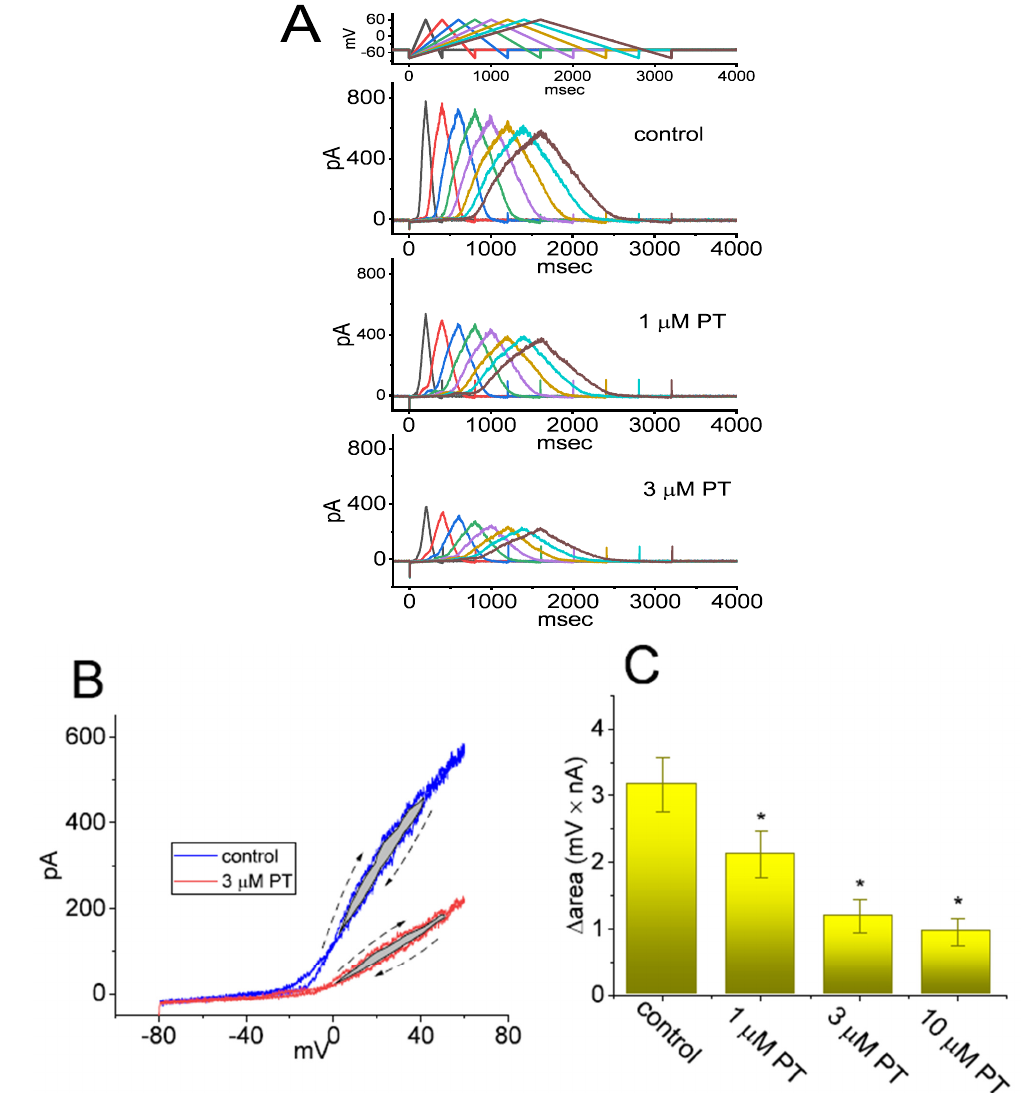
Figure 6. Effect of PT-2385 on I K(DR) activated in response to upright isosceles-triangular ramp voltage (ITRV) with varying durations (from 0.4 to 3.2 s), utilized to mimic different depolarizing or repolarizing slopes of bursting patterns in electrically excitable cells. Cells were bathed in Ca 2+ -free Tyrode’s solution containing 1 µM TTX and 0.5 mM CdCl 2 , and the pipet was filled with K + -enriched solution. ( A ) Representative current traces activated by the uppermost voltage-clamp ITRV profile, which were obtained in the absence (upper) and presence of 1 µM PT-2385 (middle) or 3 µM PT-2385. Of note, there was a mild decline in peak I K(DR) activated by ITRV with increasing ramp-pulse durations. The uppermost part shows the voltage-clamp profile delivered. In ( B ), the effect of PT-2385 (3 µM) on voltage-dependent hysteresis (i.e., the relationship of forward or backward I K(DR) versus membrane voltage) activated in response to ITRV with a duration of 3.2 s (or with a ramp speed of ±87.5 mV/s) is illustrated. Current trace in blue color is the control, while that in red was taken after exposure to 3 µM PT-2385. Dashed arrows in ( B ) indicate the direction of I K(DR) over which time goes during the elicitation by ITRV. ( C ) Effect of PT-2385 (1, 3, and 10 µM) on the ∆ area (i.e., area under the curve activated during the upsloping and downsloping end of ITRV) of voltage-dependent hysteresis elicited by ITRV with a ramp speed of ±87.5 mV/s (mean ± SEM; n = 7 for each bar). The shaded area indicates the curve activated during the upsloping and downsloping limb of the upright ITRV. Of note, there was an emergence of voltage-dependent hysteresis for I K(DR) activated by ITRV, and the presence of PT-2385 was concentration-dependently able to cause a progressive reduction in the ∆ area of voltage hysteresis of the current. * Significantly different from control (i.e., PT-2385 was not present, and currents were evoked by ITRV with ramp speed of ±87.5 mV/s) ( p < 0.05).